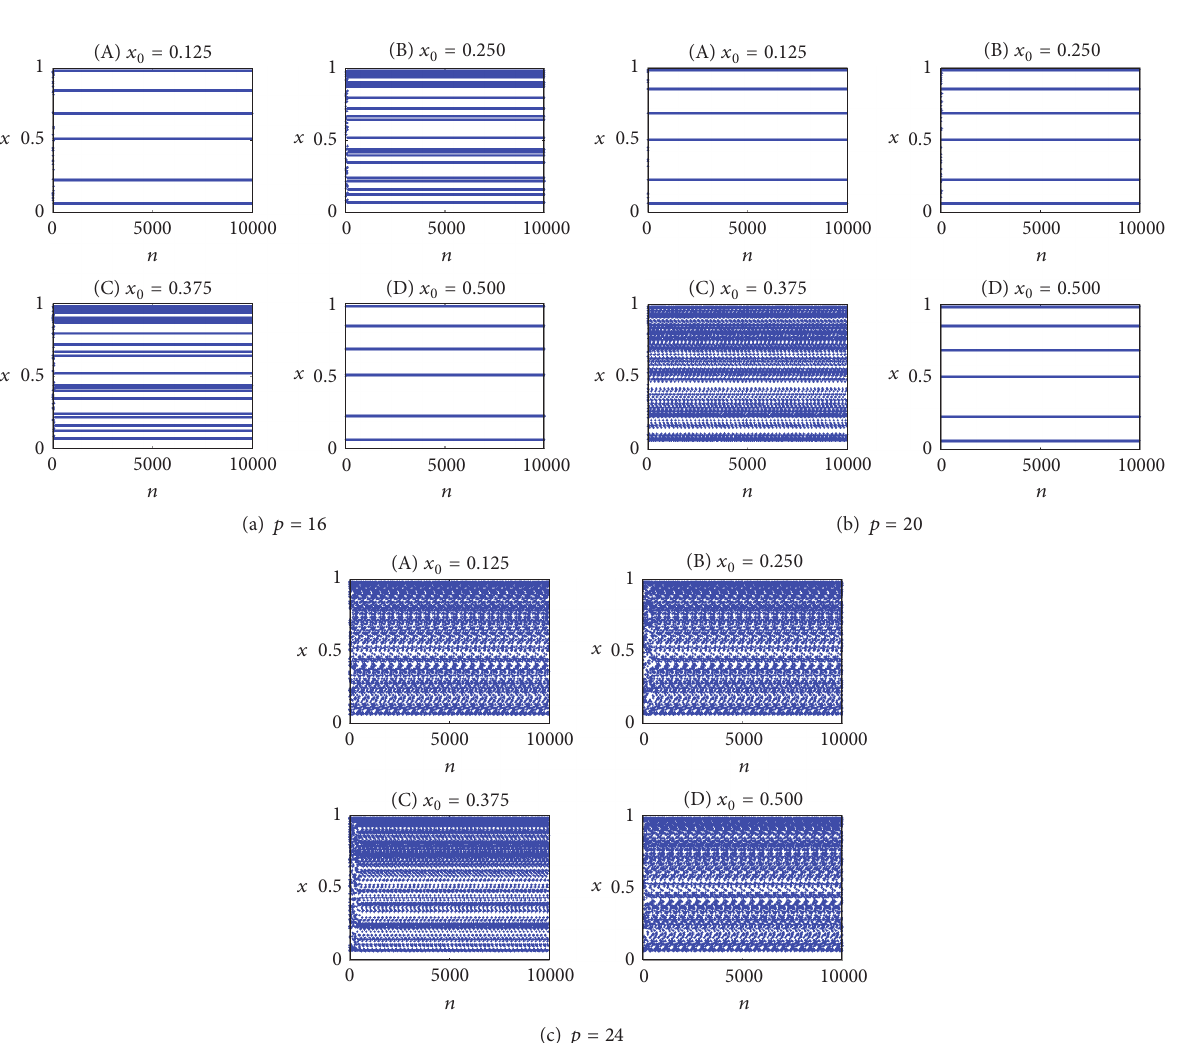
which are generated by finite precision logistic map